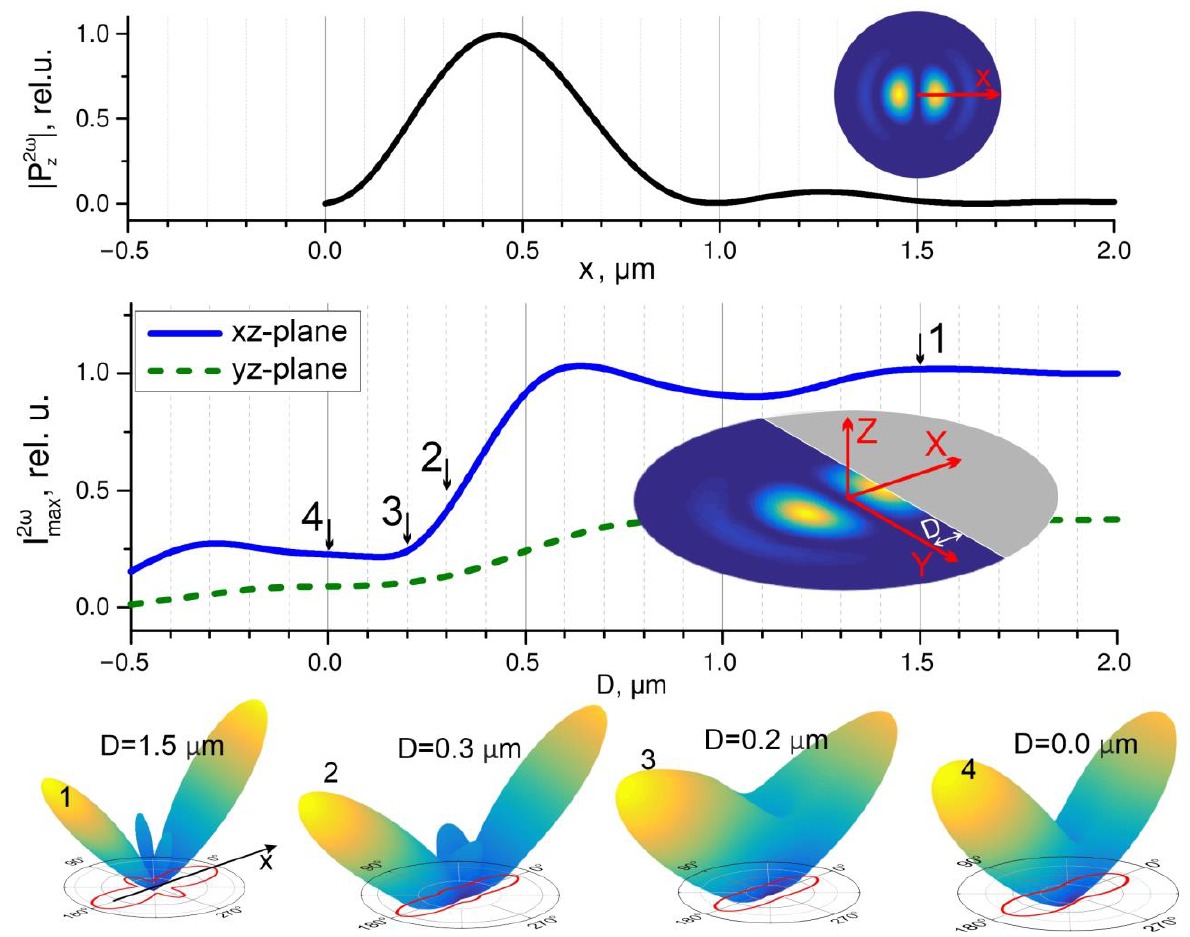
Figure 3. ( Upper row ): radial distribution of the nonlinear polarization (| P z 2ω |) at the surface possessing χ (2)zzz -component of the second order susceptibility and excited by a linearly x -polarized beam; inset: 2D-map of the polarization. ( Middle row ): maxima of the intensity of the SH radiation in xz - (solid curve) and yz -planes (dashed curve) vs. distance between the beam center and the edge of the nonlinear region ( D ); the axis and D are designated in the inset; negative D corresponds to the beam center falling over the edge. ( Lower row ): second harmonic radiation patterns for D = 1.5 μm (1), D = 0.3 μm (2), D = 0.2 μm (3), D = 0.0 μm (4); contours: maximal SH intensity vs. azimuthal